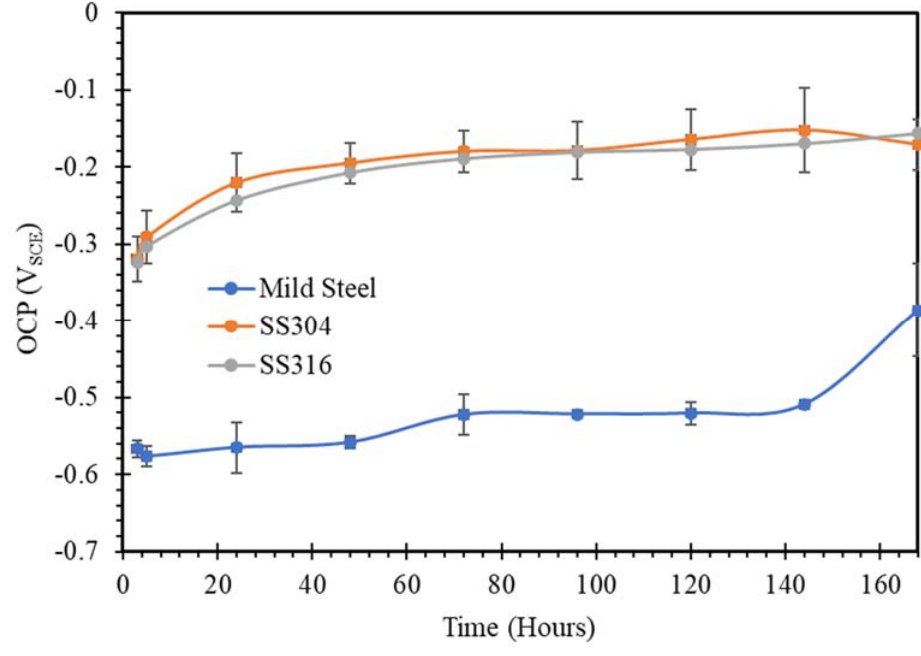
Figure 3. OCP vs. time plots of mild steel, SS304 and SS316 in SWSSNC solution.